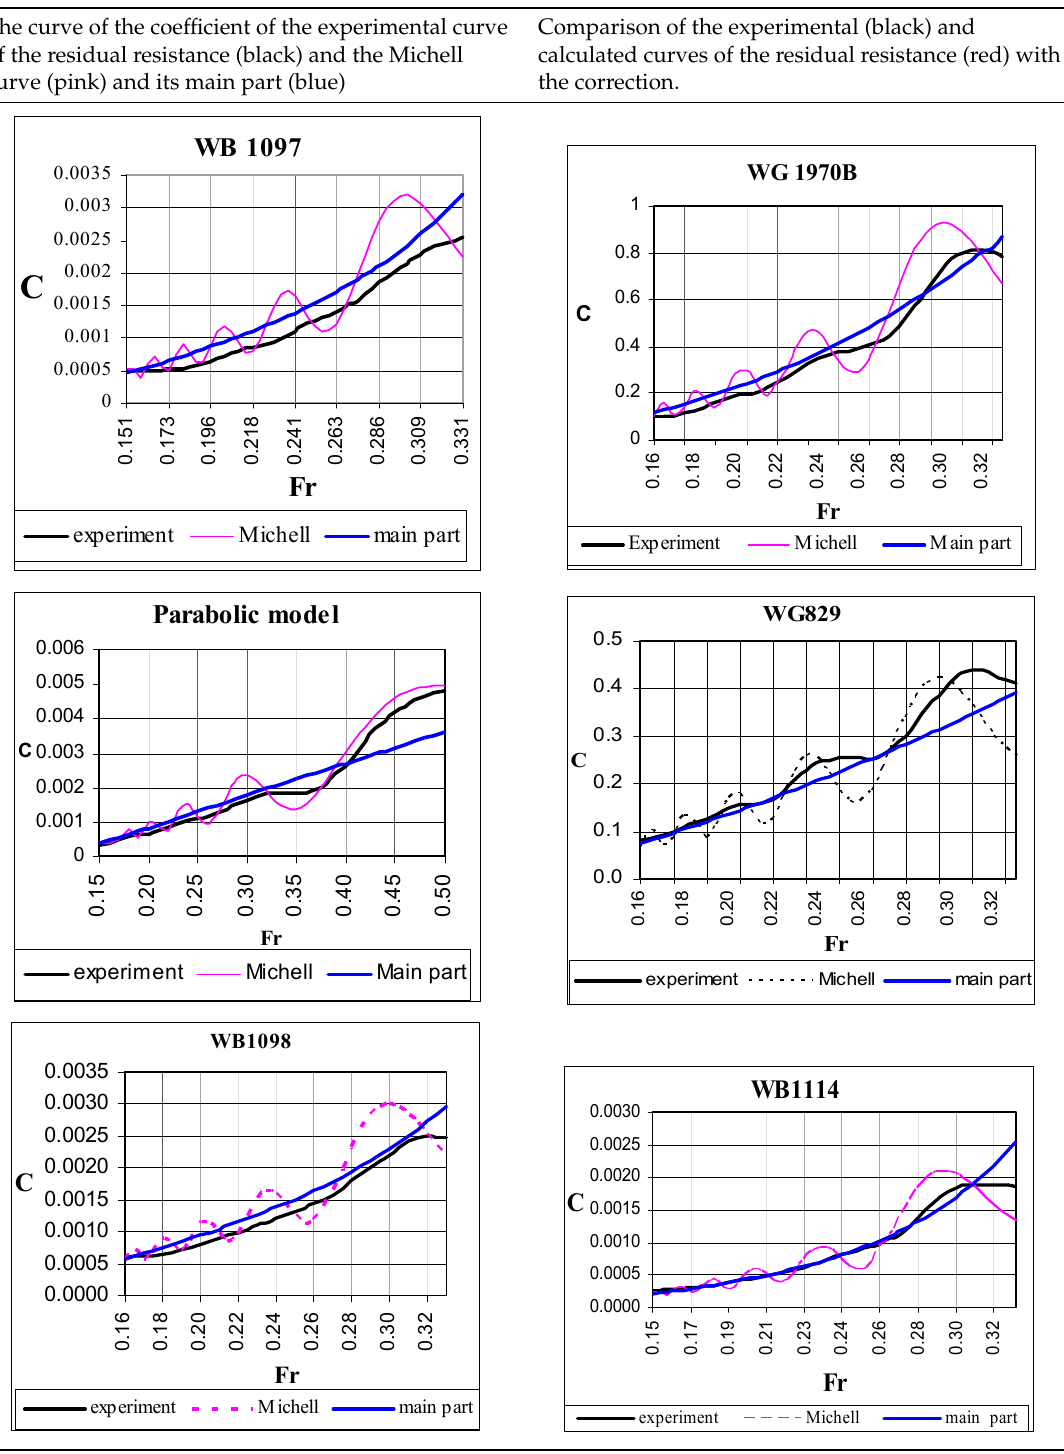
Comparison of the experimental (black) and calculated curves of the residual resistance (red) with the